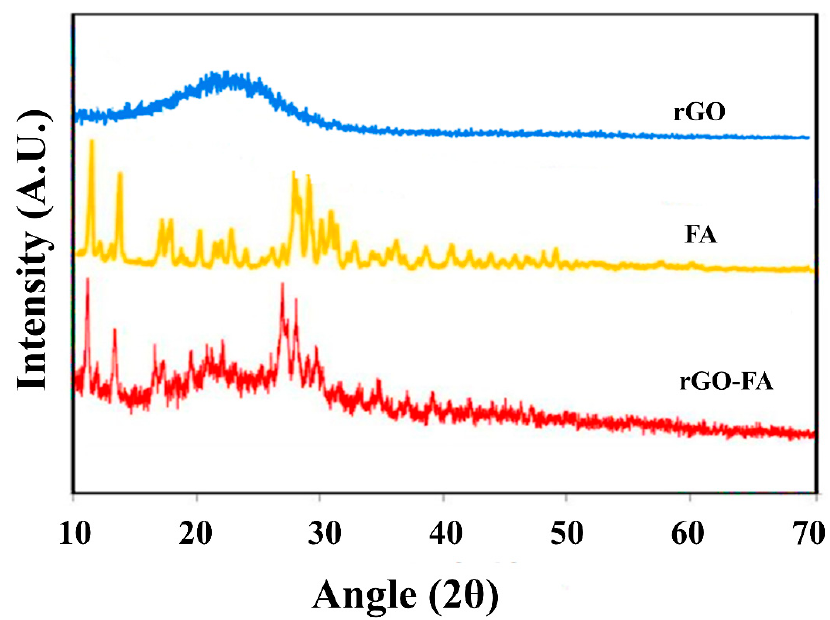
Figure 3. XRD analysis of dried rGO, FA, and rGO-FA.